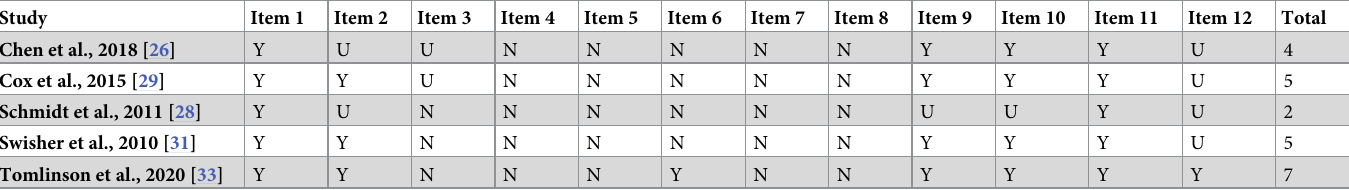
Table 3. CASP Scores for Single Cohort